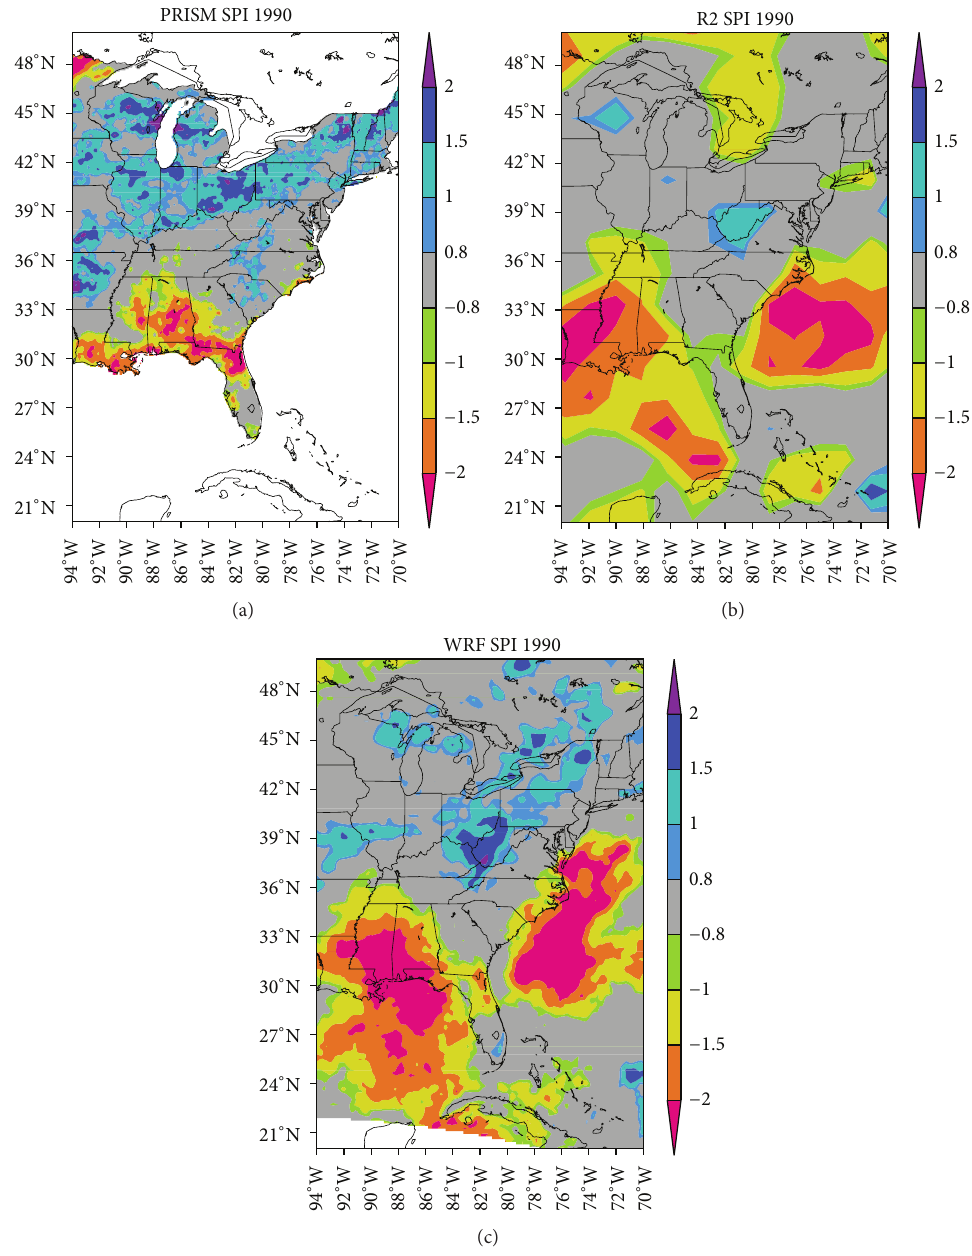
Figure 8: As in Figure 7, but for the period ending in October